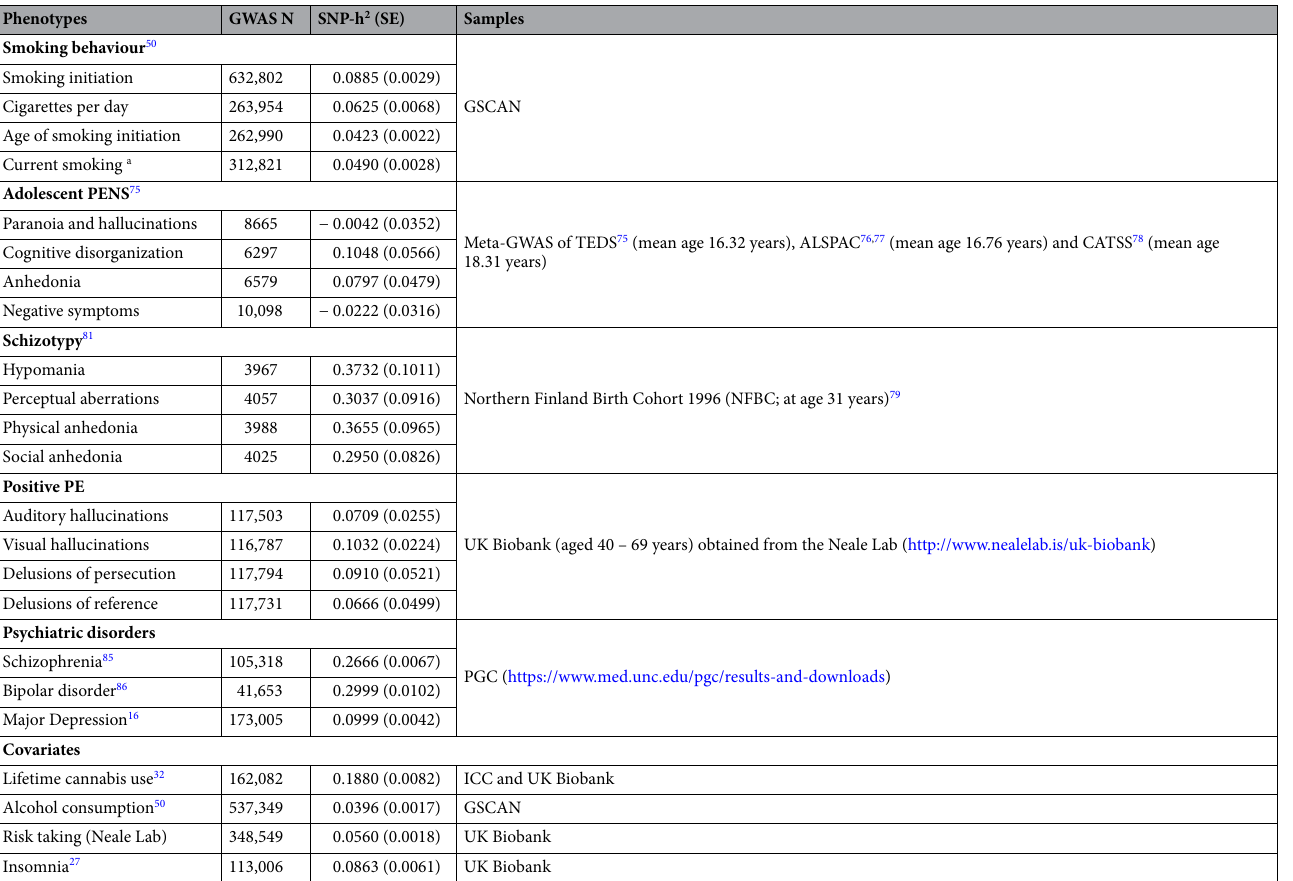
Table 3. Summary statistics, phenotypes and sample sizes. GSCAN GWAS and Sequencing Consortium of Alcohol and Nicotine use, PENS psychotic experiences (PE) and negative symptom traits, TEDS Twins